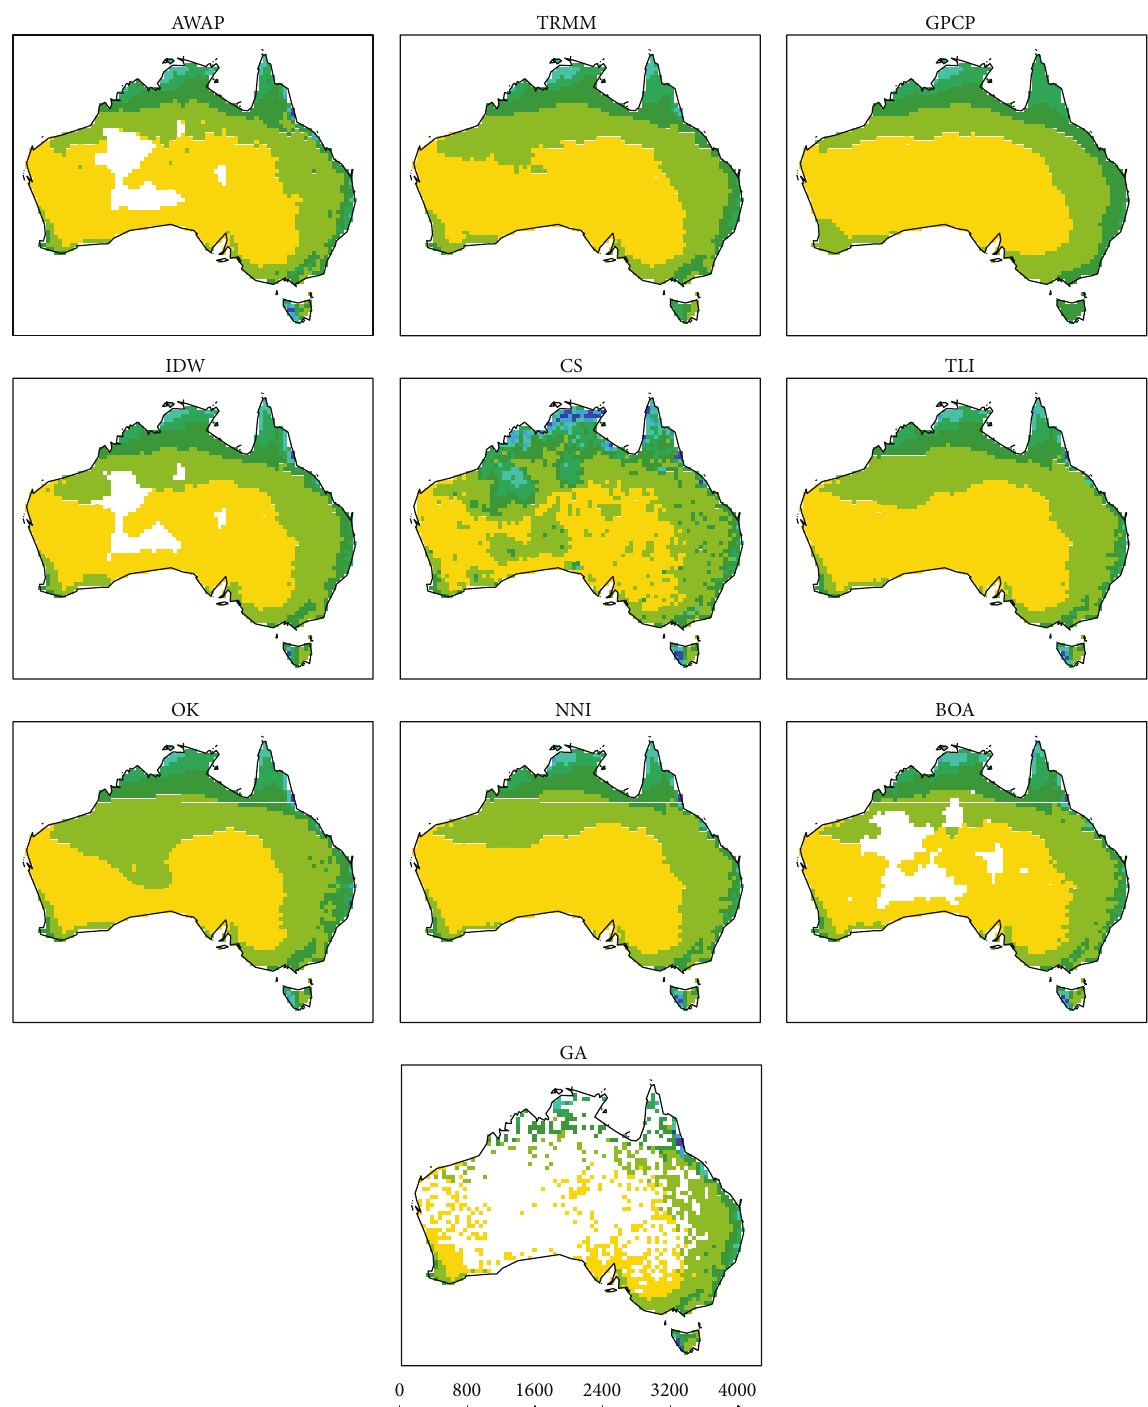
Figure 2: Maps of total annual precipitation at each grid point of Australia averaged over the period from 1998 to 2013, using three existing gridded datasets (AWAP, TRMM, and GPCP) and seven other gridded datasets calculated for the purposes of this study based on daily precipitation data from the GHCN-Daily dataset. Refer to the text for more details. Units: